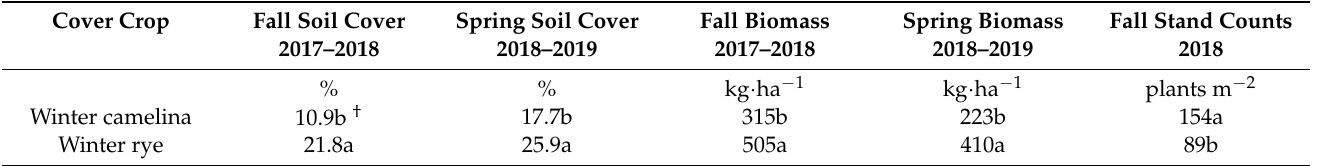
3.2. Cover Crops Soil Green Cover and Biomass in Treatments Interseeded into Soybean The analysis of variance indicated that the soybean yield was significantly different for row spacing, but none of the cover crop metrics were significantly different (Table 8). The differences in soybean maturity and cover crop type resulted in significant observed